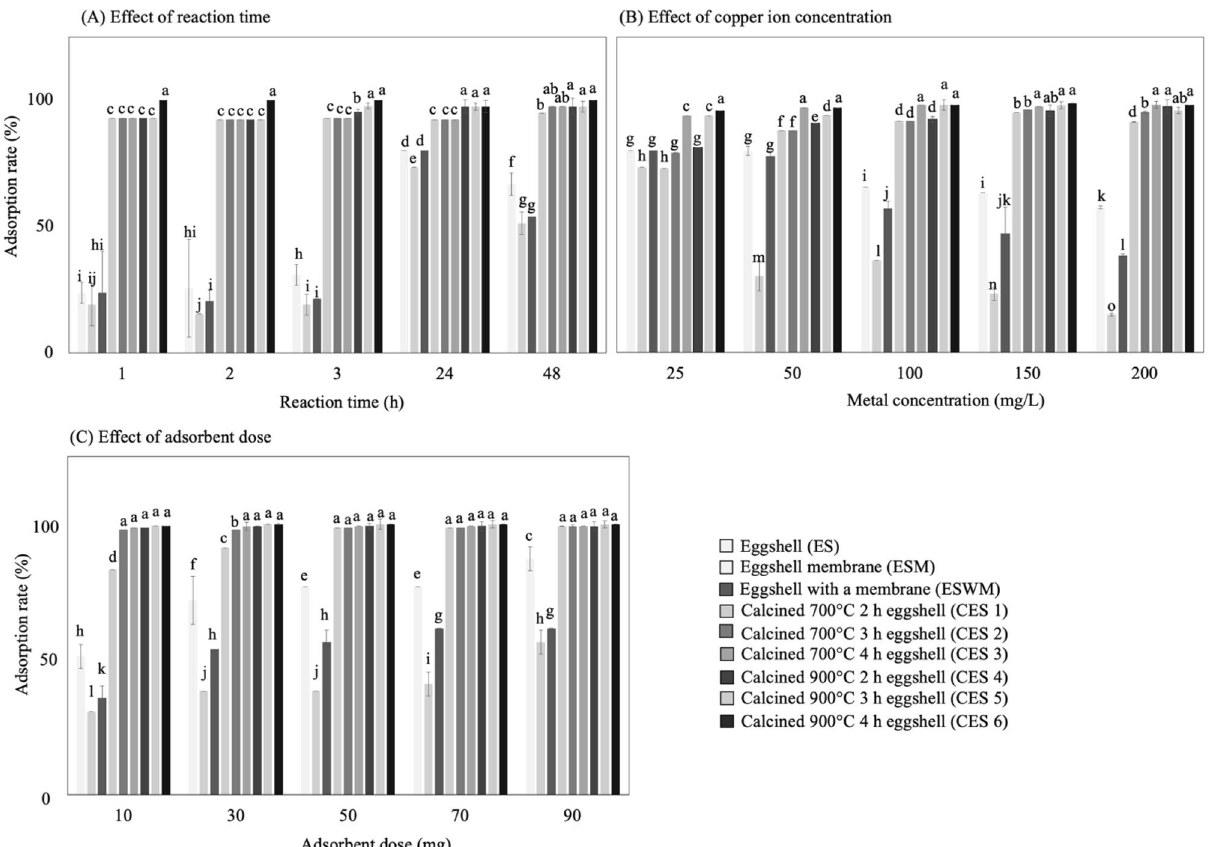
Figure 1. The adsorption rates of differently treated eggshells were influenced by single factors ( A ) reaction time, ( B ) copper ion concentration, and ( C ) dose of adsorbent,